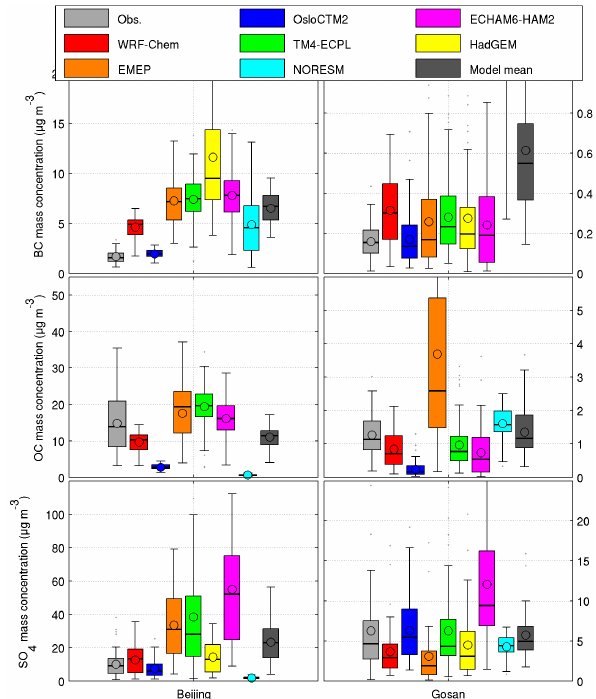
Figure 12. Comparison of observed and simulated box-and-whisker plots for BC, OC and sulphate: mean (circle), median (central line), the 25th and 75th percentiles (box edges). The whiskers encompass values from the 25th − 1.5 × (75th–25th) to the 75th + 1.5 × (75th– 25th). This range covers more than 99% of a normally distributed data